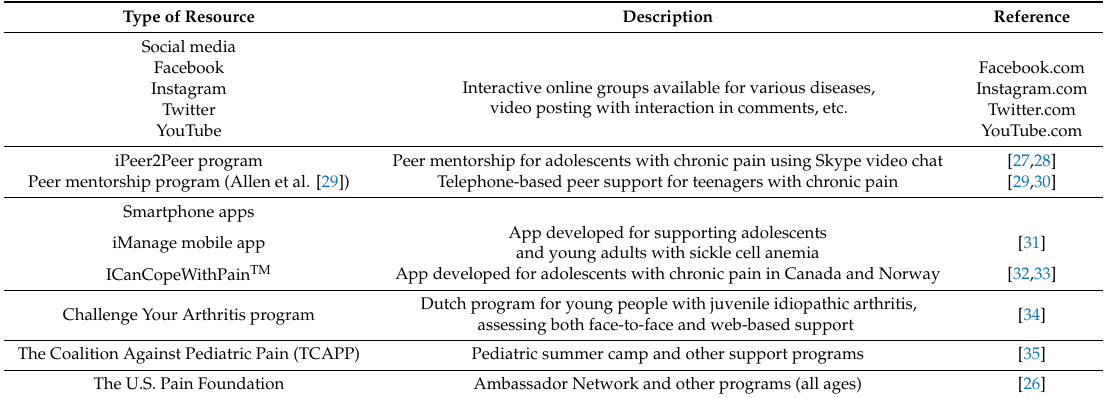
Table 1. Available resources and feasibility studies of peer support for adolescents with chronic pain. Type of